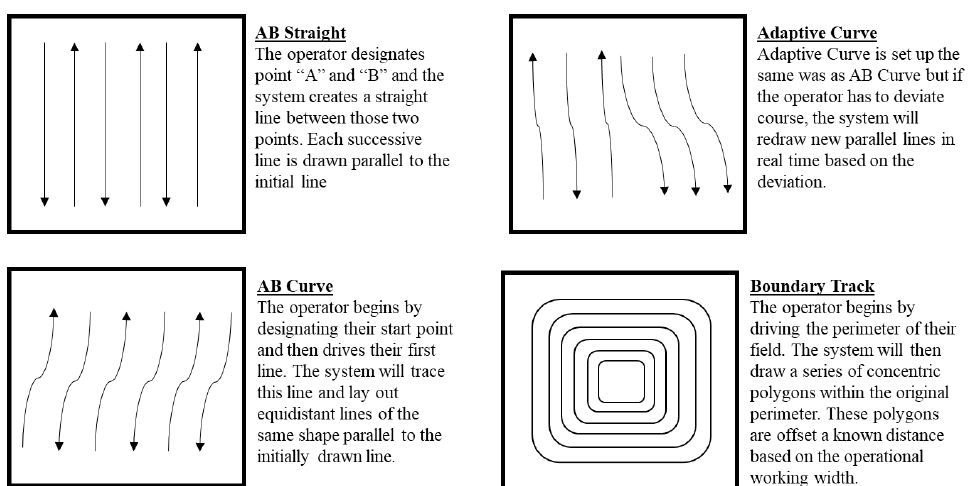
Figure 2. Common guidance line patterns available in autosteer systems.